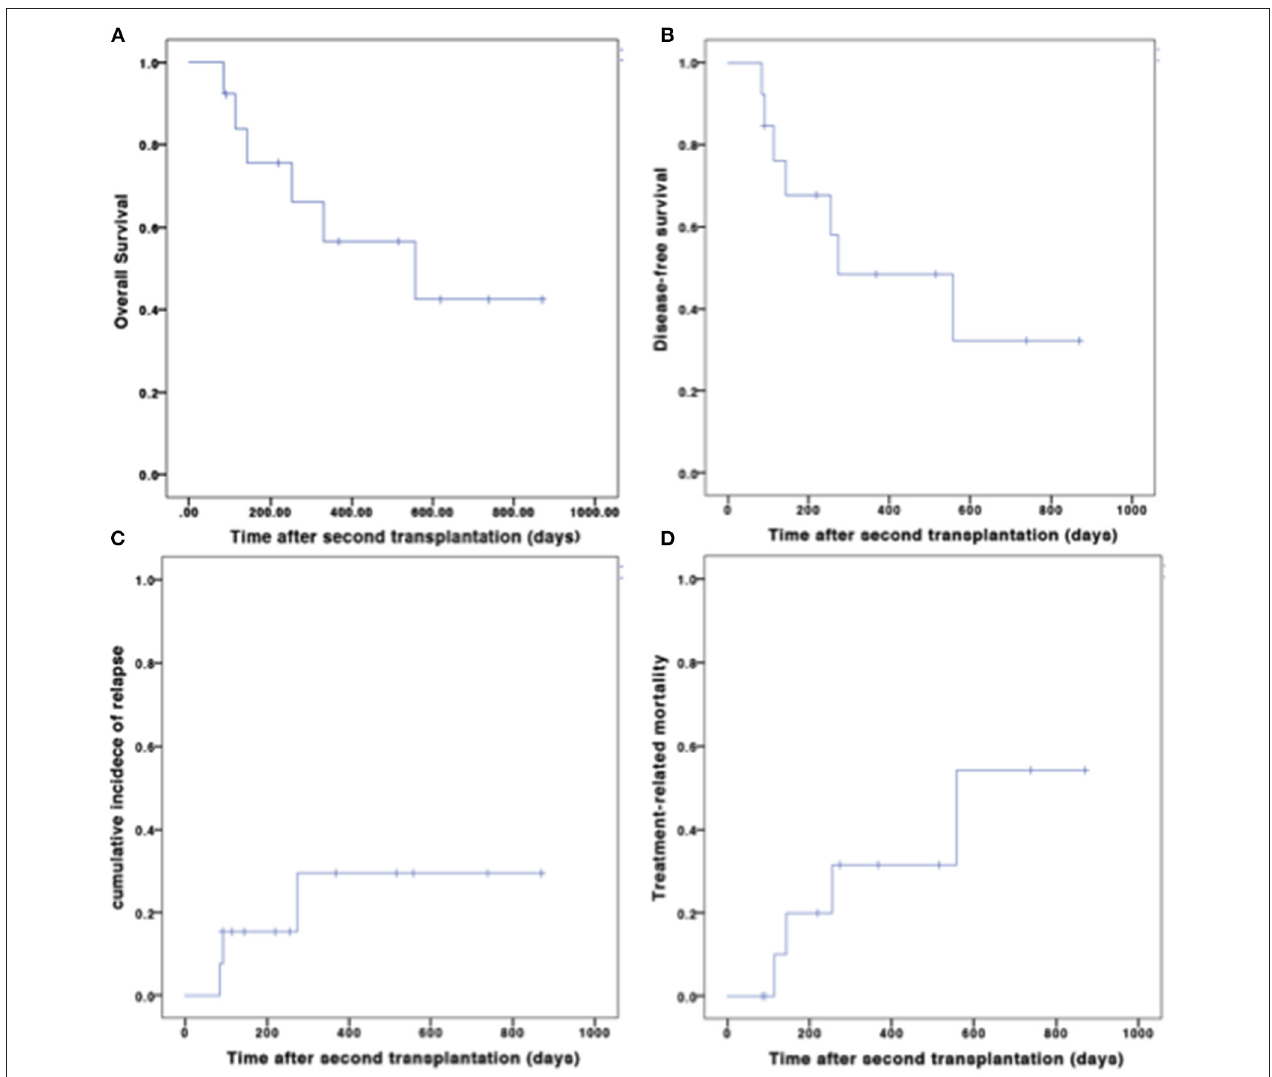
FIGURE 3 | Outcomes after second transplantation. (A) OS; (B) DFS; (C) CIR; (D)